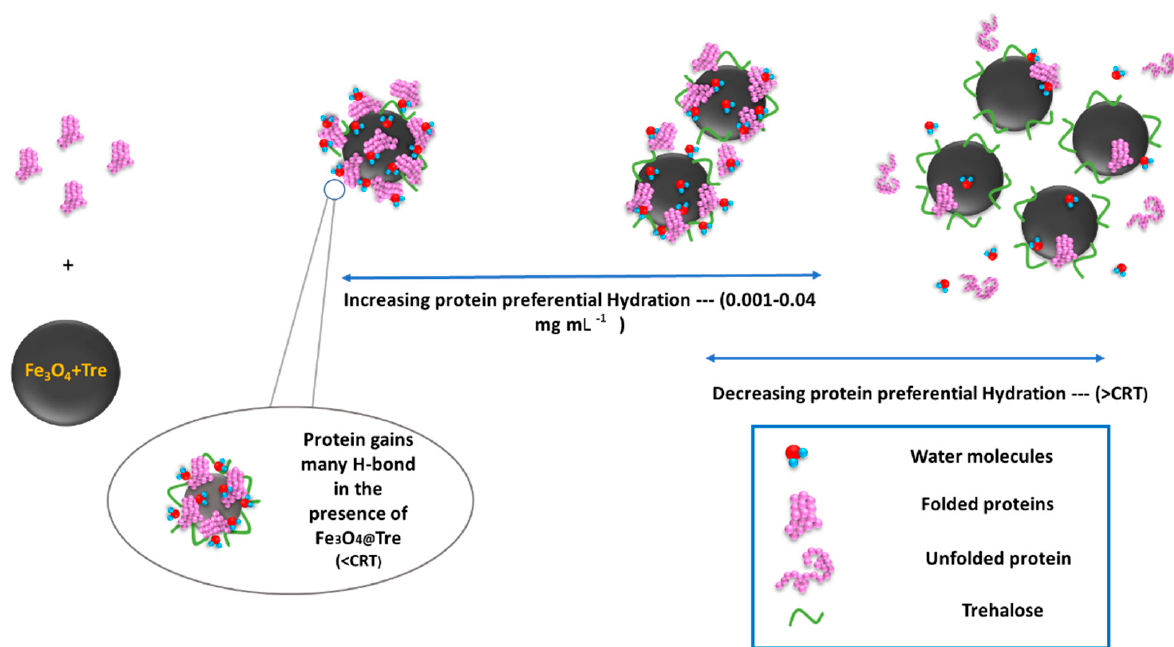
Figure 9. Schematic of protein change according to the NPs concentrations.